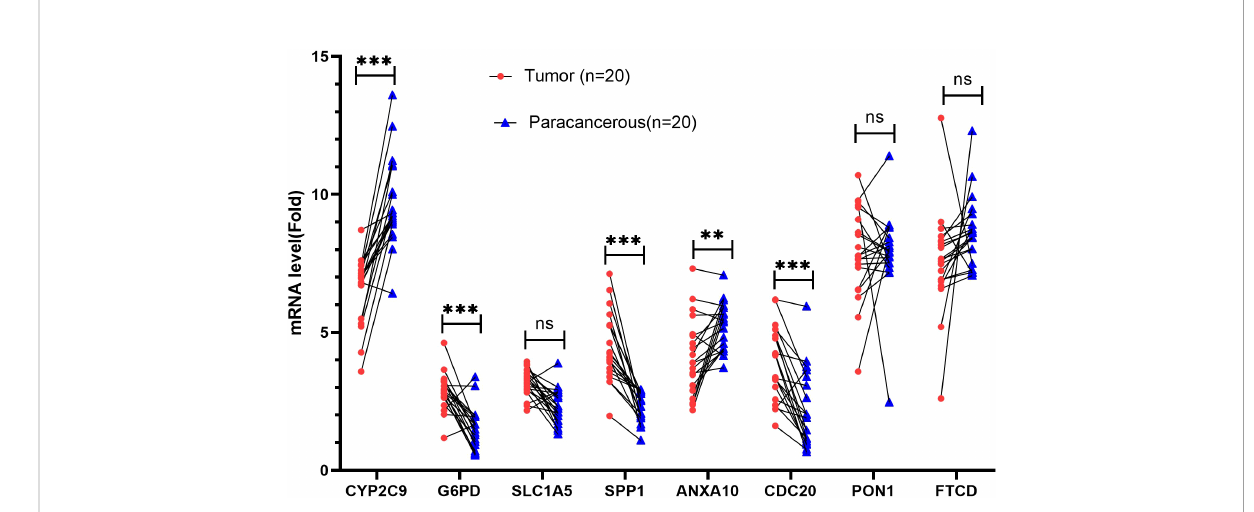
FIGURE 13 Validation of mRNA expression by real-time PCR. mRNA expression of eight genes associated with MARCH ligase in 20 HCC tissues and paracancerous tissues. ns, not statistically signi fi cant; ** p < 0.01; *** p <